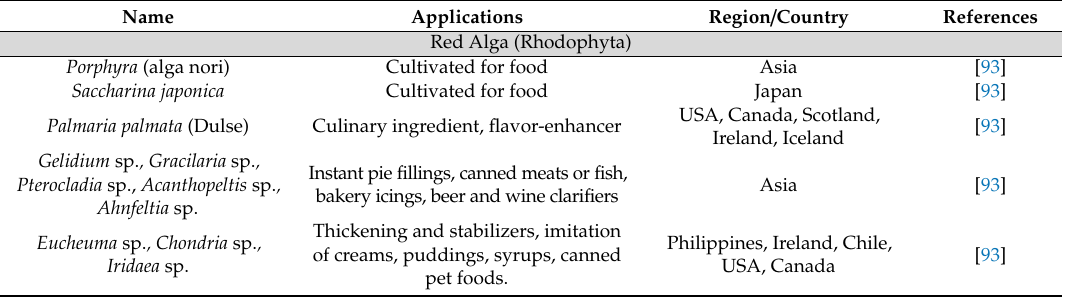
Table 4. Food and feed applications of the main red, brown and green